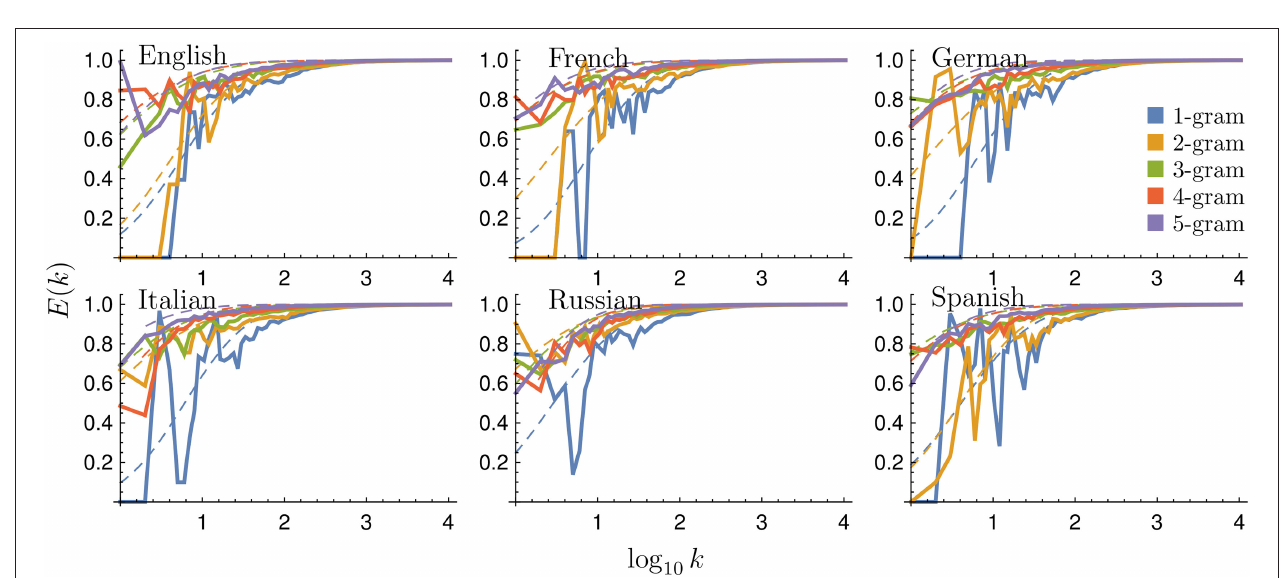
FIGURE 9 | Rank entropy for different languages and N -grams. Binned rank entropy E ( k ) as a function of rank k for all languages and N values considered (continuous lines). We also include fits according to the sigmoid in Equation (1) (dashed lines), as in Figure 2 .